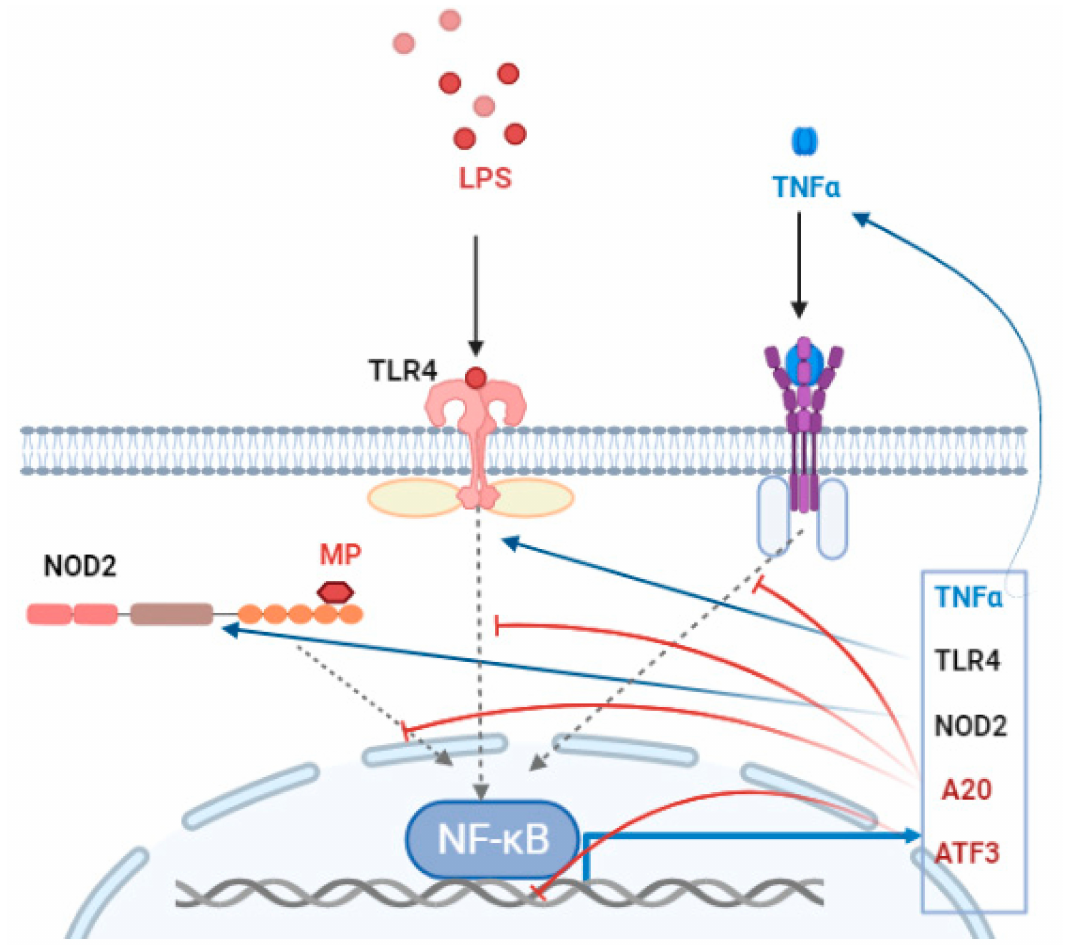
Figure 3. Positive and negative feedback during lipopolysaccharide (LPS) and muramyl peptide (MP)—induced inflammation. Blue arrows—activation of inflammation; red lines—suppression of